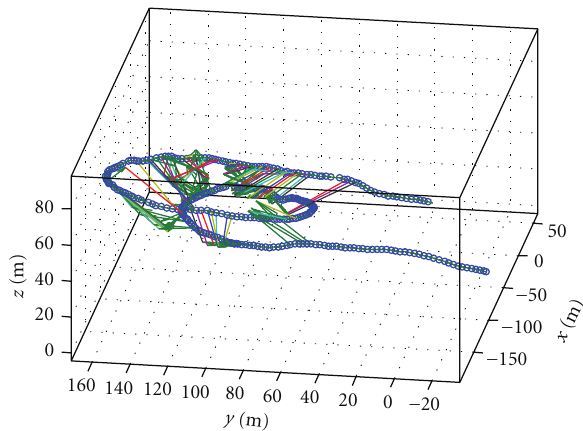
Figure 14: The airship trajectory with the loop-closing constraints indicated by the arrows. The lines represent the error which is